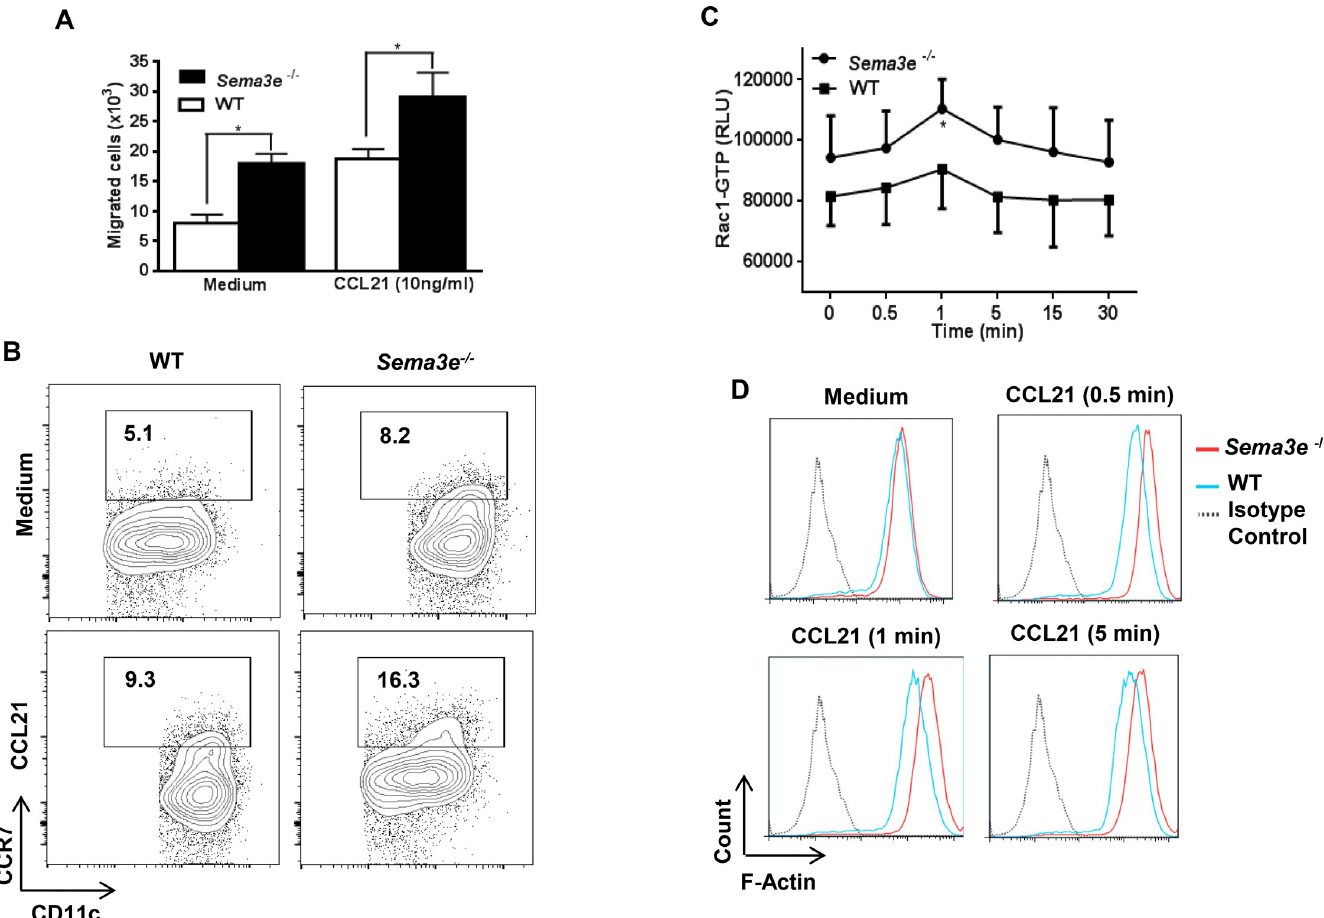
Fig 1. Role of Sema3E in regulation of BMDC migration. Basal and CCL21-induced migration of BMDC from Sema3e -/- and WT mice was assessed by transwell assay in vitro (A). Surface expression of CCR7 is increased in BMDC from Sema3e –/– mice compare to those of WT littermates as determined by flow cytometry at the baseline or after stimulation with CCL21 (B). Rac1 GTPase activity was compared between BMDC from Sema3e –/– and WT mice before and after CCL21 stimulation by performing G-LISA (C). Kinetic study of actin polymerization by Phalloidin staining at the baseline and upon stimulation with CCL21 revealed higher F-actin content in the absence of Sema3E over time (D). Data represent at least three independent experiments. (n = 3–6 per group, � P < 0 . 05 ).